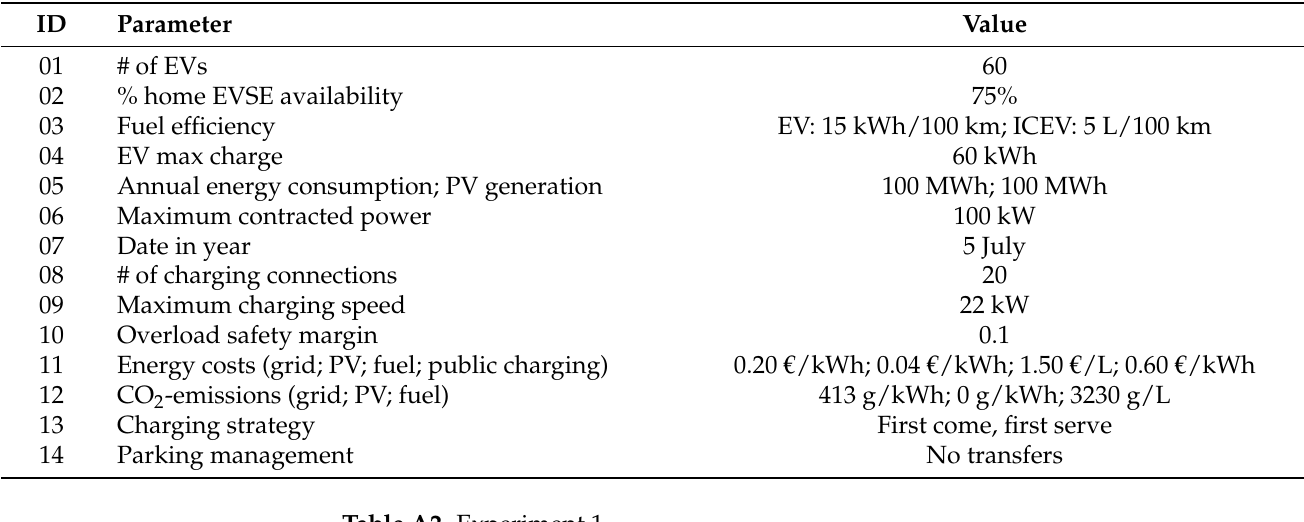
Table A1. Reference case for the computerized model verification.